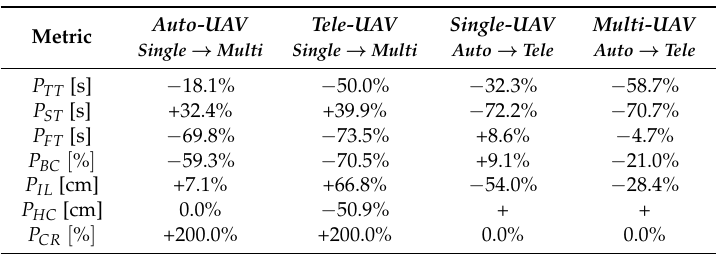
Table 3. Experimental results: comparison between single-UAV system and multi-UAV system and comparison between automatic control method and teleoperation method. For example,